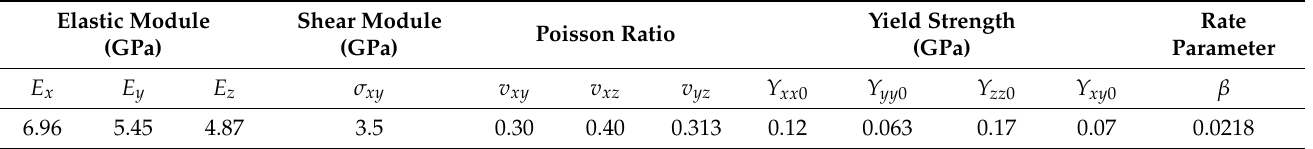
Table 3. Constitutive model parameters of C/P composites.